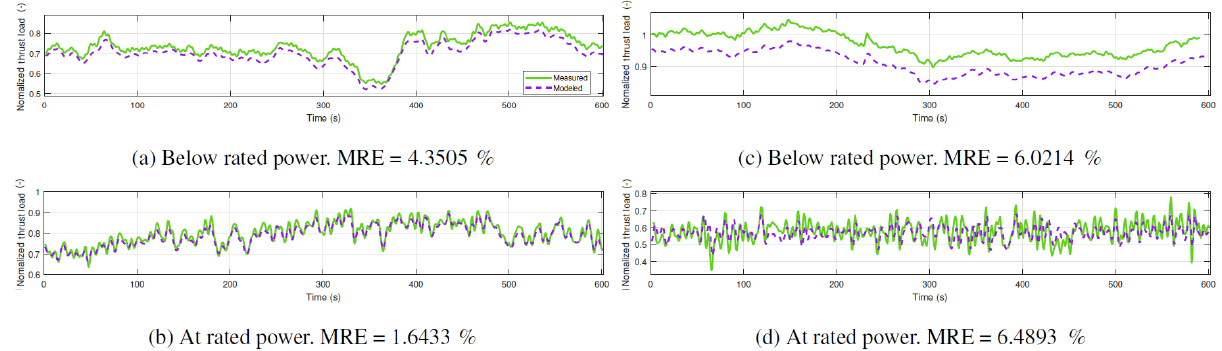
Figure 7. Time series (spanning 10min) of modeled and measured thrust loads below rated (a, c) and at rated power (b, d) . For each operational state, the time series with the highest averaged absolute error is shown (c, d) . MRE shows the averaged absolute relative error over